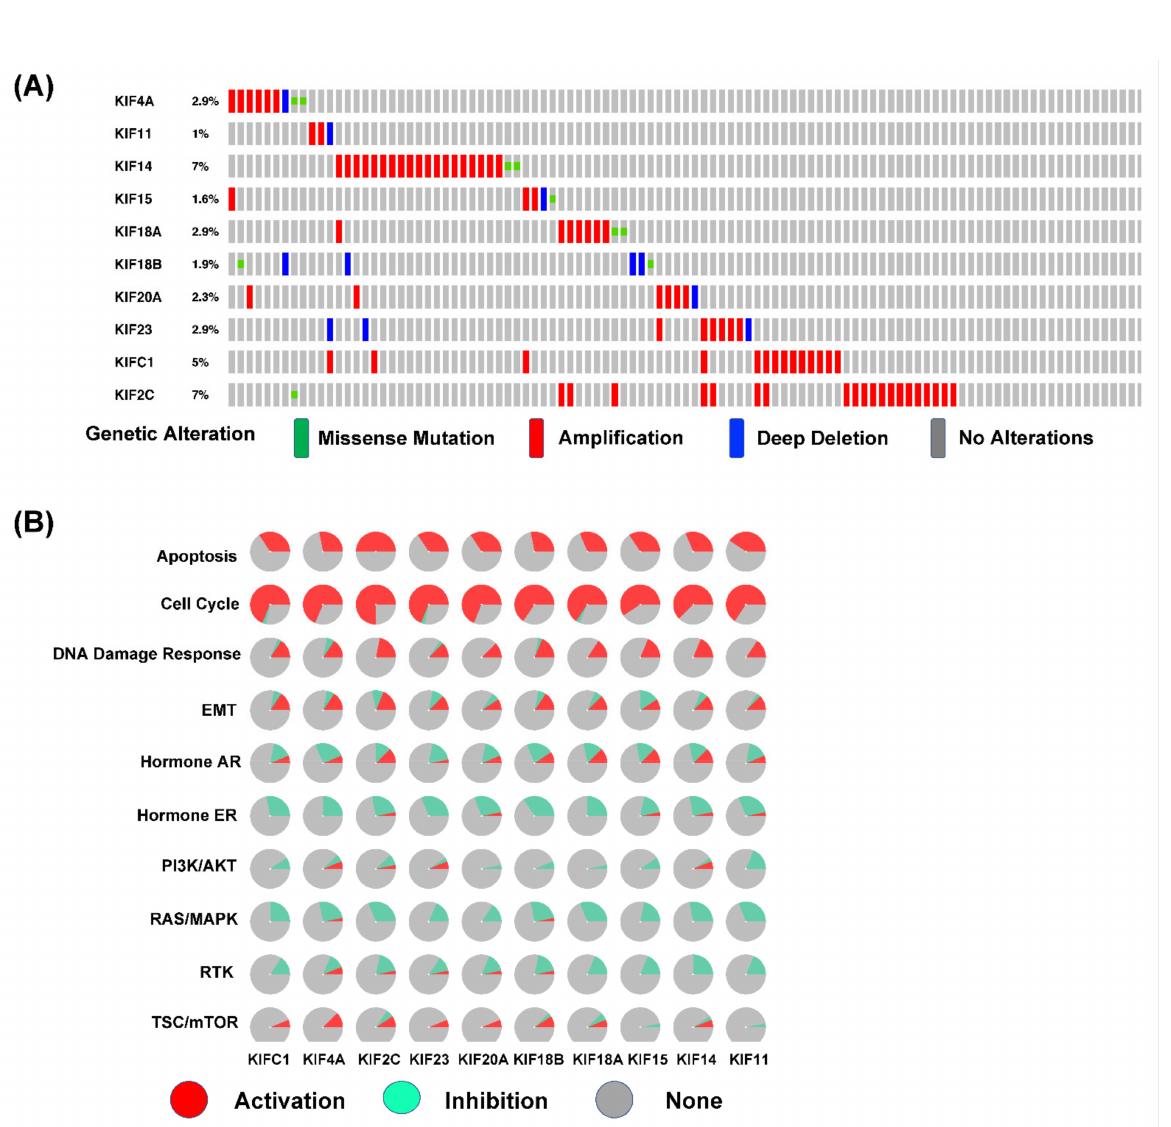
Figure 4. Genetic alterations and cancer-related pathways of ten overexpressed mitotic KIFs in OC. ( A ) Genetic alterations of ten overexpressed mitotic KIFs in OC (cBioPortal). Genetic mutation events include missense mutation, amplification, and deep deletion. KIF14 and KIF2C rank the relatively highest two genes of genetic alterations, and their mutation rates are both 7%; ( B ) the roles of ten overexpressed mitotic KIFs in the famous cancer-related pathways (GSCALite). The red, turquoise, and grey parts present activation, inhibition, and none,